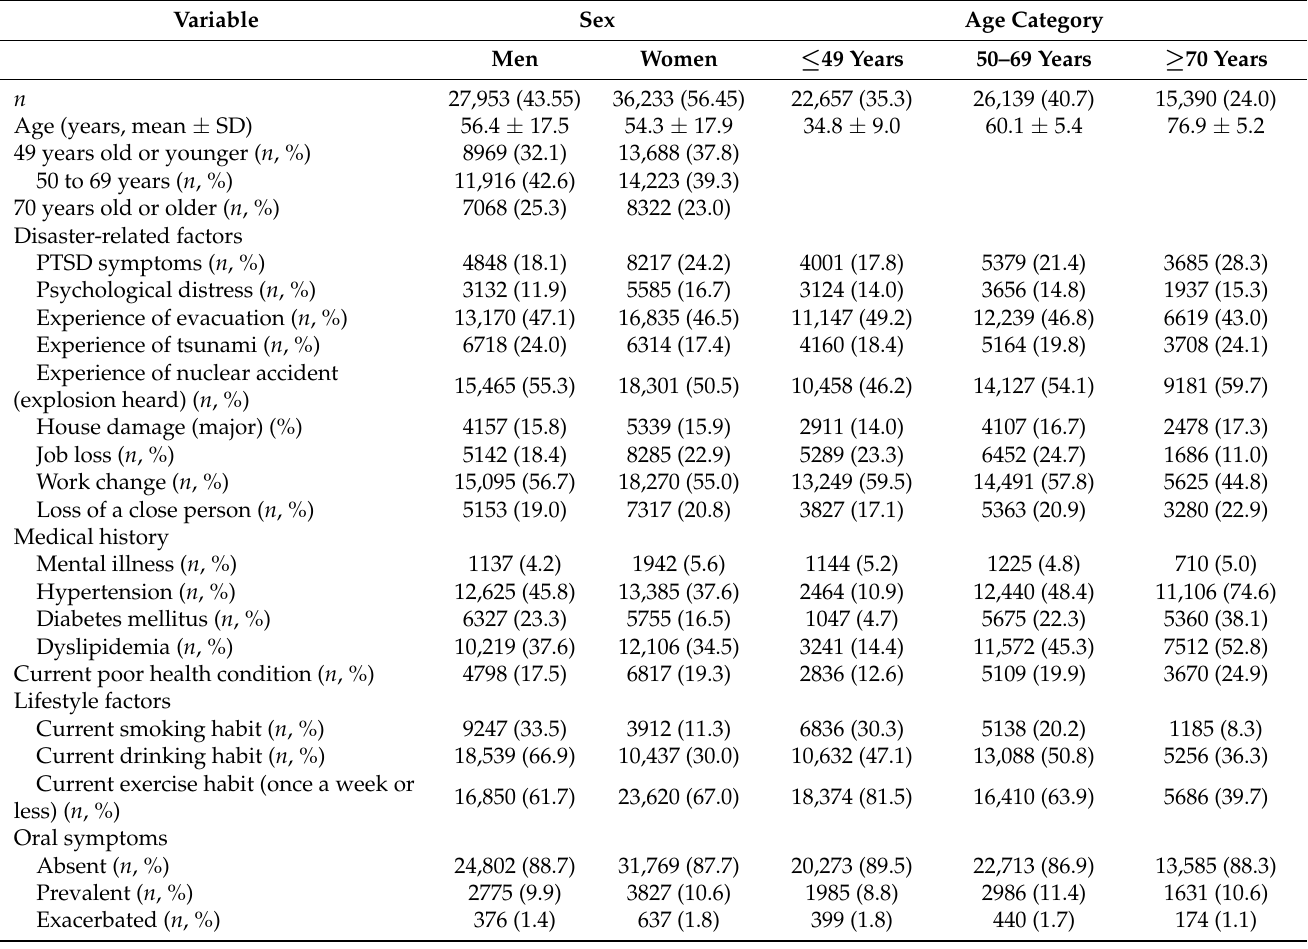
Table 1. Prevalence of oral symptoms and basic background information of 64,186